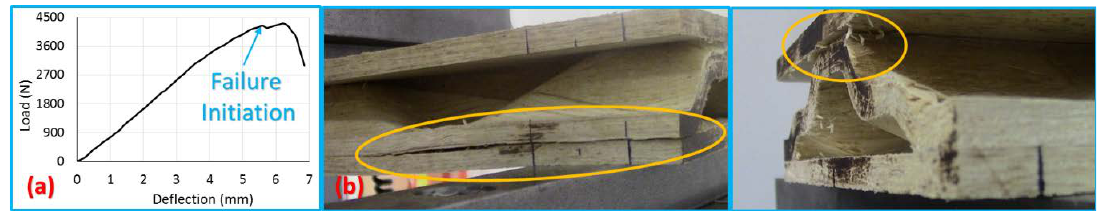
Figure 9. Four-point bending test of the sandwich specimens in the longitudinal direction: ( a ) typical load–deflection curve, ( b ) failure mode, delamination due to interfacial shear between the outer plies and the core.